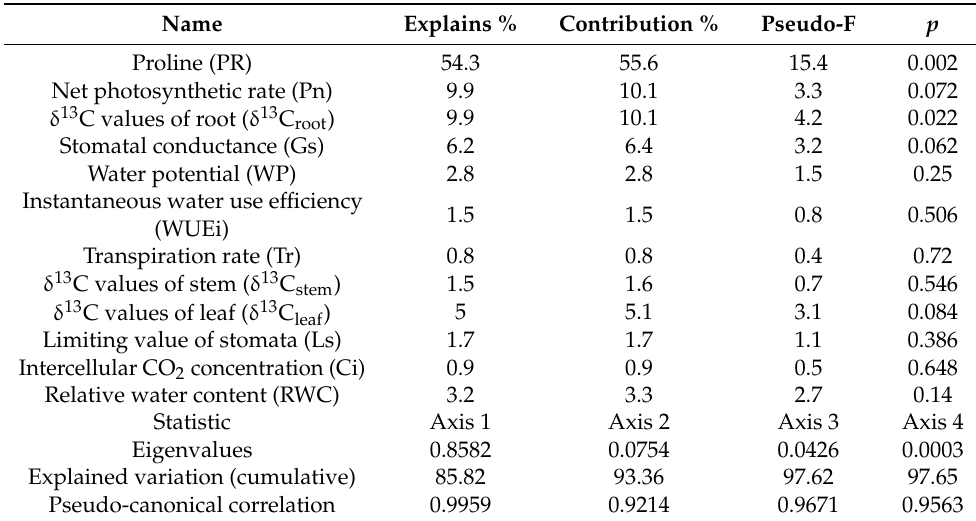
Figure 7. Results by redundancy analysis between biomass and physiological indexes of Glycyrrhiza uralensis . δ 13 C leaf , δ 13 C stem , and δ 13 C root represent the δ 13 C values of leaf, stem, and root; LB, SB, and RB represent the leaf biomass, stem biomass, and root biomass; R/S, PR, RWC, WP, Pn, Tr, Ci, Gs, WUEi and Ls represent the root to shoot ratio, proline, relative water content, water potential, net photosynthetic rate, transpiration rate, intercellular CO 2 concentration, stomatal conductance, instantaneous water use efficiency, and limiting value of stomata, respectively. Table 3. Results by redundancy analysis ordination with the first two axes and Monte Carlo permuta- tion